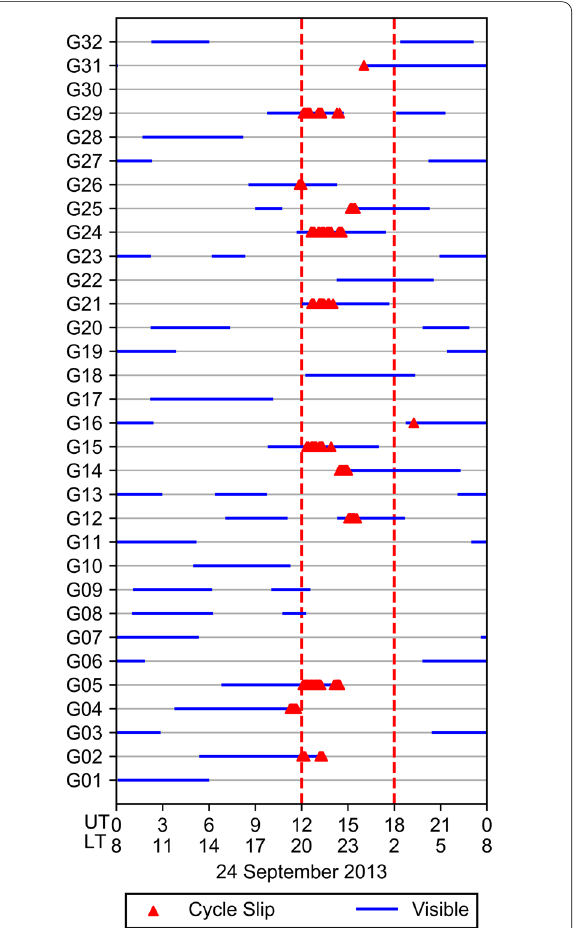
Fig. 11 Spatial distribution of cycle slips on GPS L1 ( a ) and L2 ( b ) signals derived from the HKPC station on 24 September 2013. The blue lines denote the trajectory of the GPS satellites projected on the plane at the altitude of 350 km. The red triangles on the blue line represent cycle slips